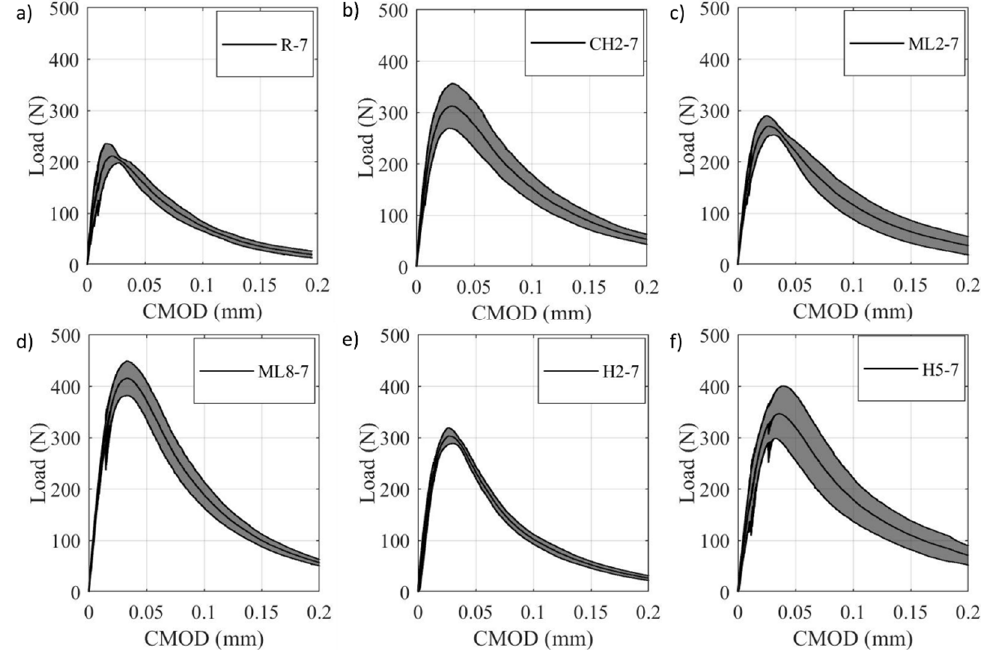
Figure 12. Comparison of CMOD mean and variance response for the ( a ) reference and carbon fiber reinforced cementitious composite mixes (( b ) CH2, ( c ) ML2, ( d ) ML8, ( e ) H2, and ( f ) H5) at seven days of age. Each graph represents the mean of five tested samples.